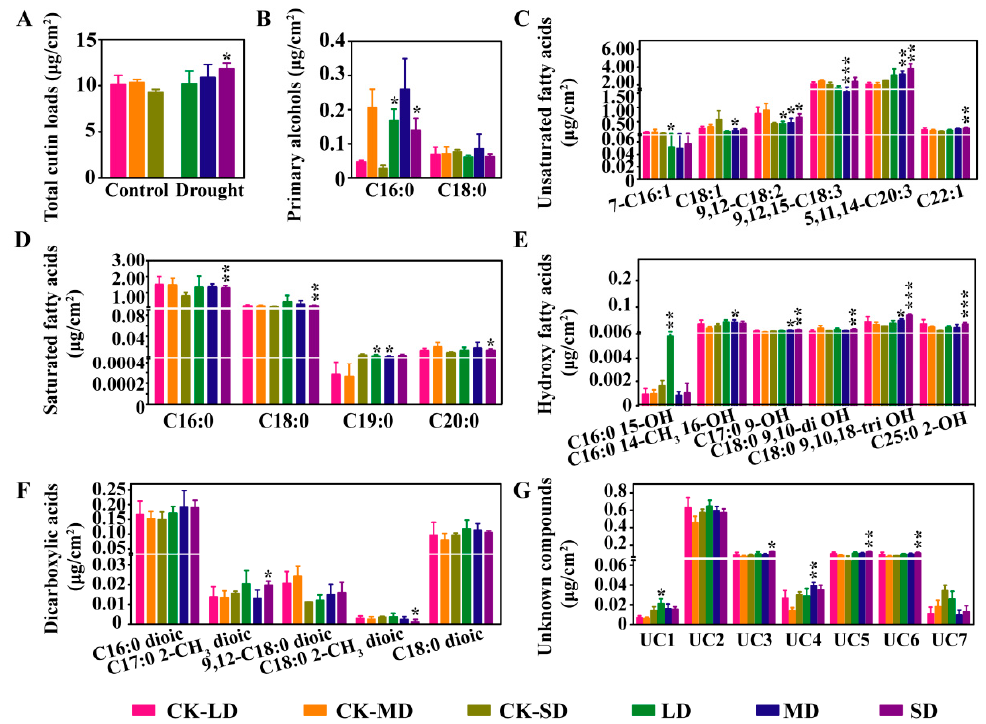
Figure 3. Quantitative analysis of cutin components by GC-MS under varying degrees of drought stress conditions. ( A ) Determination of total cutin content under varying degrees of drought stress. ( B – G ) Determination of primary alcohol content ( B ), unsaturated fatty acid content ( C ), saturated fatty acid content ( D ), hydroxy fatty acid content ( E ), dicarboxylic acids content ( F ), and unknown compounds content ( G ) under varying degrees of drought stress. LD, mild drought stress; MD, moderate drought stress; SD, severe drought stress; CK-LD, CK-MD and CK-SD, the respective controls of LD, MD, and SD. Statistical significance was determined by Student’s t -test. * p < 0.05, ** p < 0.01, *** p < 0.001.